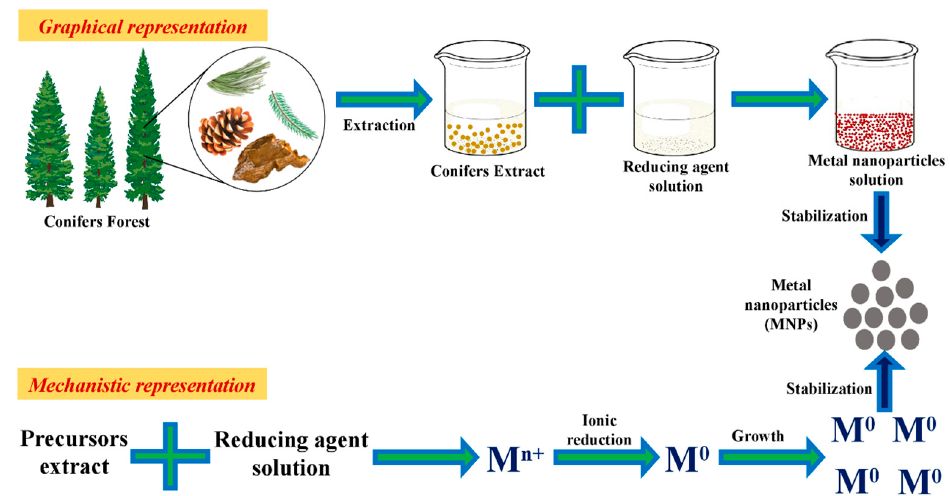
Figure 1. Graphical overview of the green synthesis protocol using conifer extracts for synthesizing metallic nanoparticles.